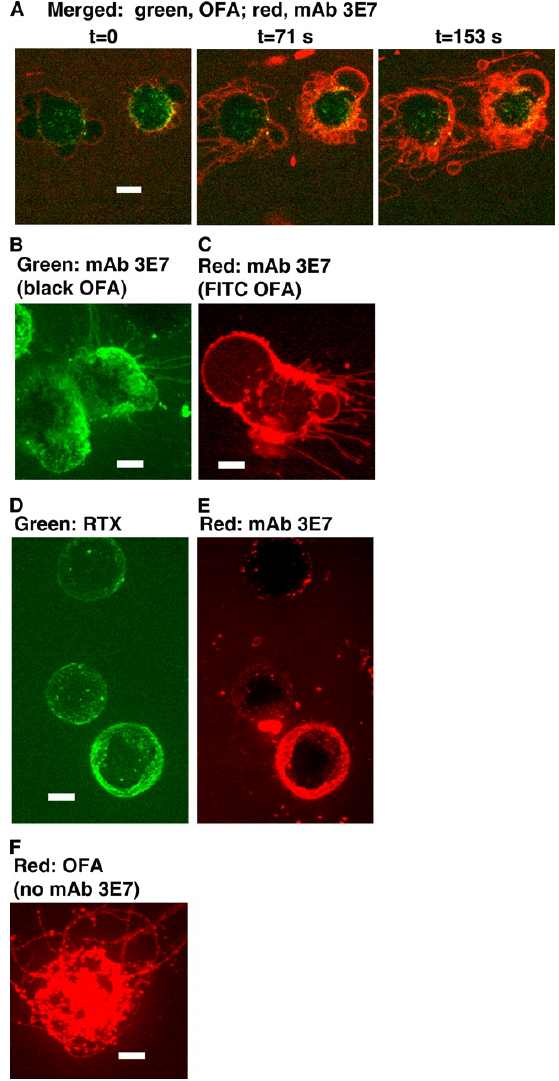
Figure 5. Binding of OFA to Daudi cells and ARH77 cells in NHS produces blebbing and streamers. ( A ), Daudi cells were opsonized with Al488 OFA, and then reacted with NHS and Al647 mAb 3E7; merged 488 nm/647 nm images at the indicated times. ( B ), ARH77 cells were opsonized with OFA, and then reacted with NHS and Al488 mAb 3E7; the 488 nm image shows mAb 3E7. ( C ), ARH77 cells were opsonized with FITC OFA, and then reacted with NHS and Al647 mAb 3E7; the 647 nm image shows mAb 3E7. ( D ) and ( E ), ARH77 cells were opsonized with Al488 RTX, and then reacted with NHS and Al647 mAb 3E7; the 488 nm image ( D ) shows RTX and the 647 nm image ( E ) shows mAb 3E7. There is neither blebbing nor streamers in panels ( D ) and ( E ). ( F ), Blebbing and streamers are generated in the absence of mAb 3E7. Daudi cells were opsonized with Al647 OFA and then reacted with NHS. The 647 nm image is displayed. Figures 4 and 5 were originally published in The Journal of Immunology . Beum, P.V. et al., 2008, Complement activation on B lymphocytes opsonized with rituximab or ofatumumab produces substantial changes in membrane structure preceding cell lysis, J.Immunol. 181:822–832. Copyright © (2008) The American Association of Immunologists, Inc. [19] .